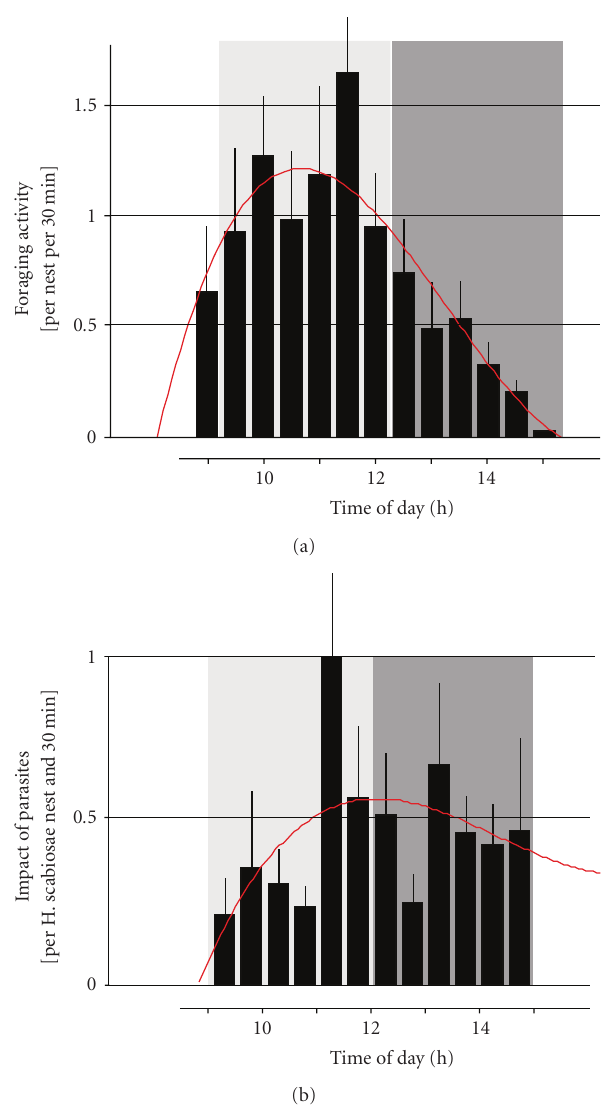
Figure 5: Summary of (a) mean foraging activities of 28 nests over three days and (b) mean impact rate of parasites as assessed at the experimental nests of the study site. Red curves, regression functions of the means (for equations, see Tables 1 and 2 and